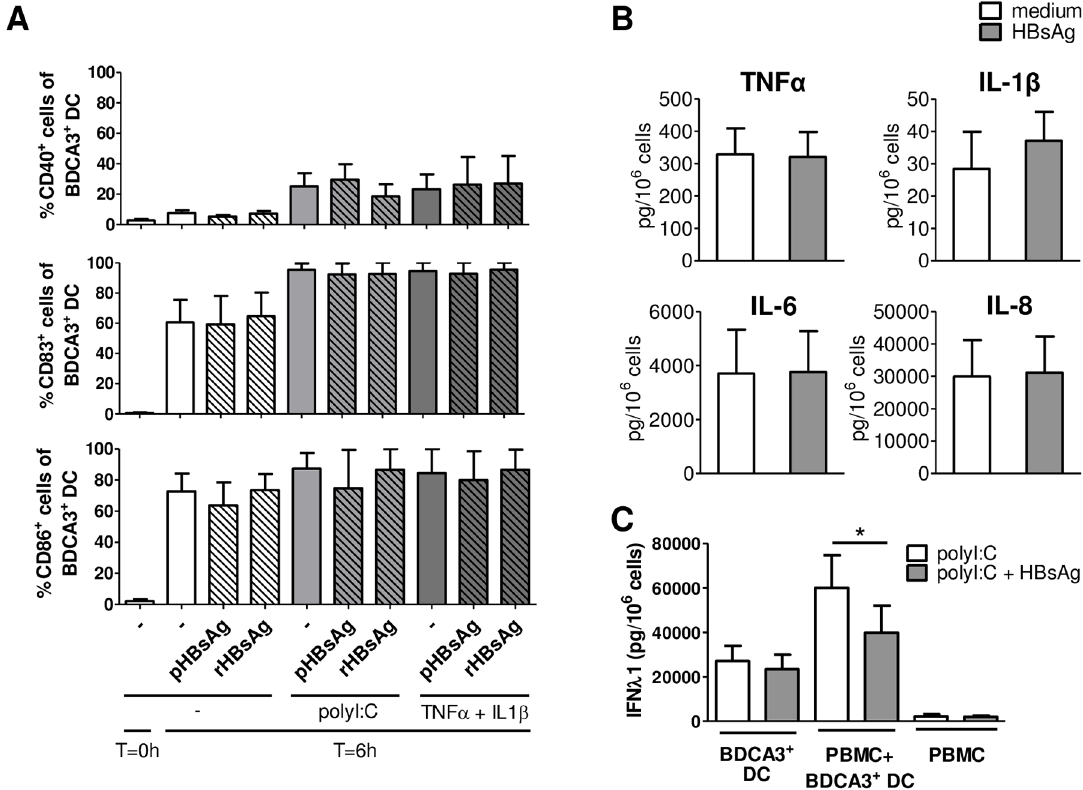
Fig 4. HBsAg does not have a direct effect on BDCA3 + DC function. (A) Isolated BDCA3 + DCs from healthy subjects were stimulated for 6 hours with or without polyI:C or TNF α and IL-1 β in the presence or absence of rHBsAg or pHBsAg. Mean ± SEM percentages of maturation marker-expressing BDCA3 + DCs are shown (n = 2 – 3). (B) Isolated BDCA3 + DCs from healthy subjects were stimulated for 24 hours with polyI:C in the presence or absence of rHBsAg. Data are shown as mean ± SEM cytokine levels determined by CBA (n = 5). (C) Isolated blood BDCA3 + DCs from healthy subjects were stimulated for 24 hours with polyI:C in the presence (n = 6) or absence (n = 7) of PMBC and/or rHBsAg, and cytokine levels in the culture supernatant were determined by ELISA (mean ± SEM). * p < 0.05 by paired Student ’ s t